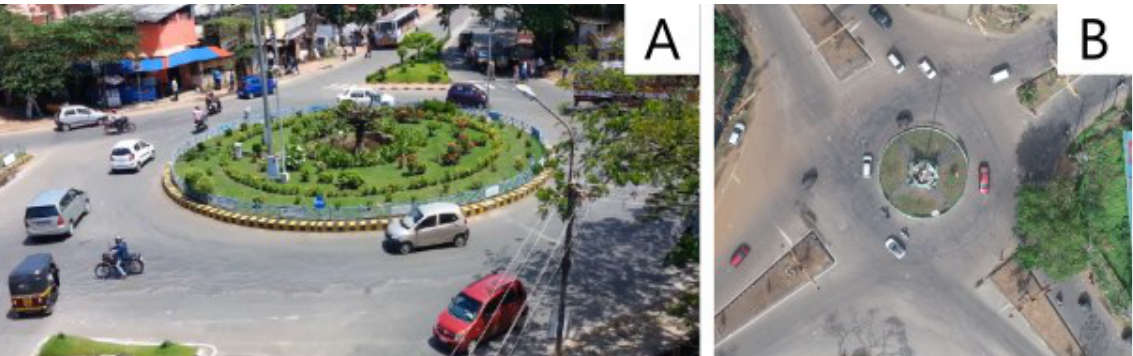
Figure 2 Examples of selected roundabout study